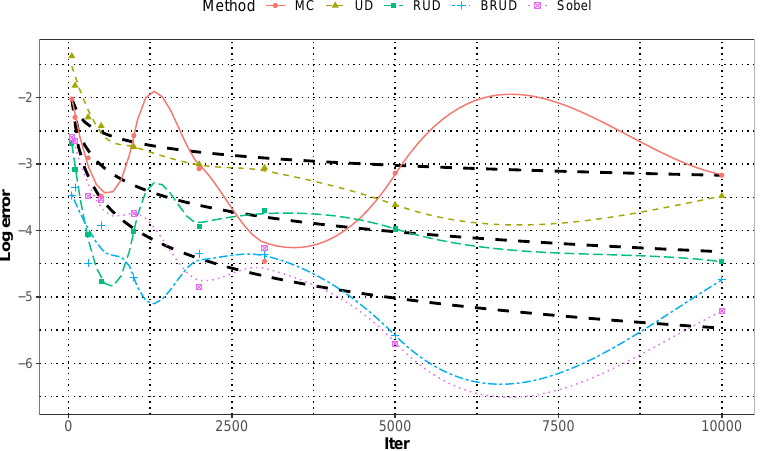
Figure 8. The approximation error of integration of g ( x ) for each runs in dimension s = 5 with Locally Weighted